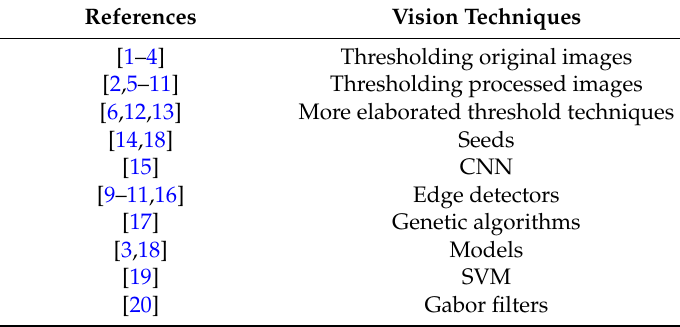
Table 1. Summarized comparisons of related